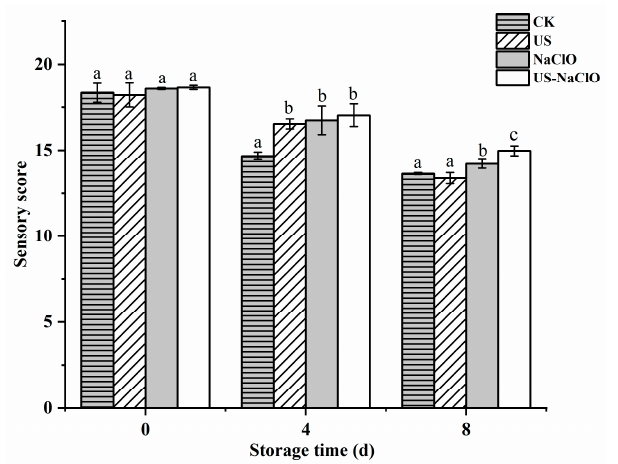
Figure 8. Effects of US, NaClO and US-NaClO treatment on sensory content of fresh-cut cucumber during storage. Different letters indicate significant differences among treatments at same storage time ( p < 0.05).